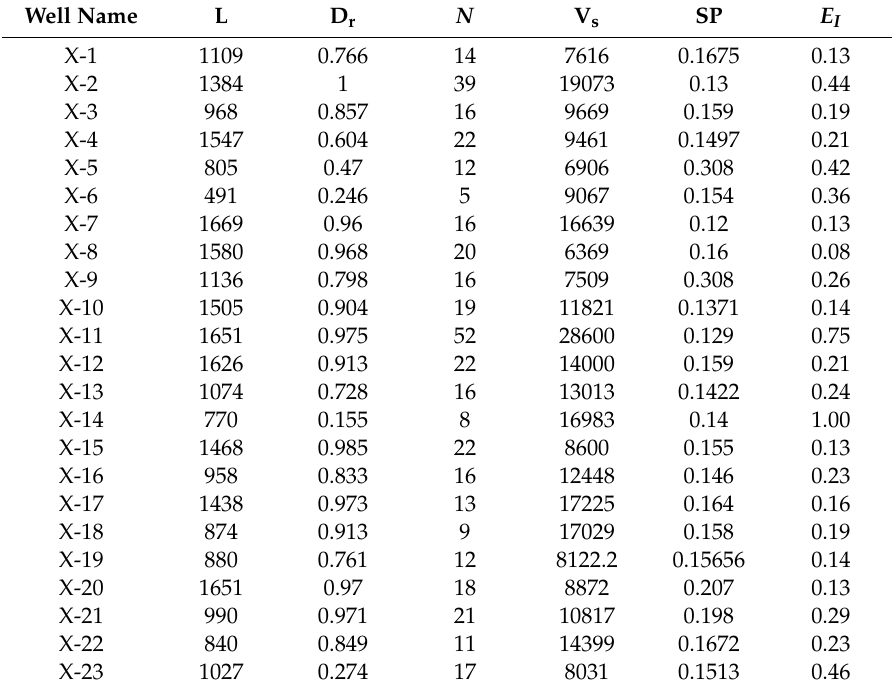
Table A2. Statistical table of fracturing engineering parameters of tight oil wells in the target